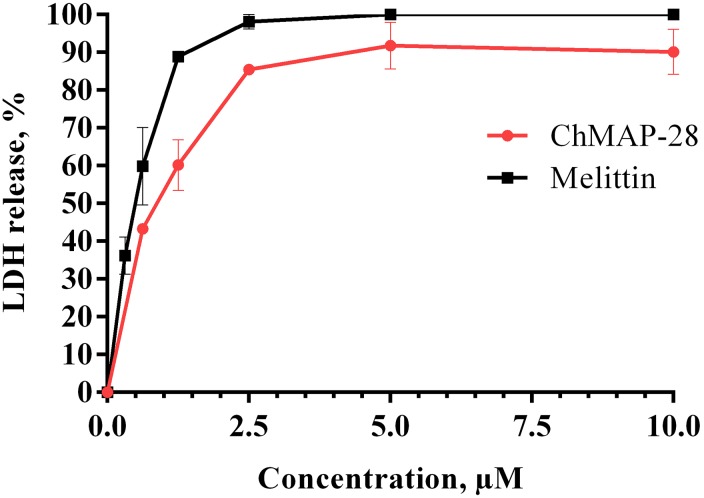
Lactate dehydrogenase assay of HL-60 cells treated with ChMAP-28 or melittin. Data represent the mean values ± SD for three independent series of triplicated experiments.